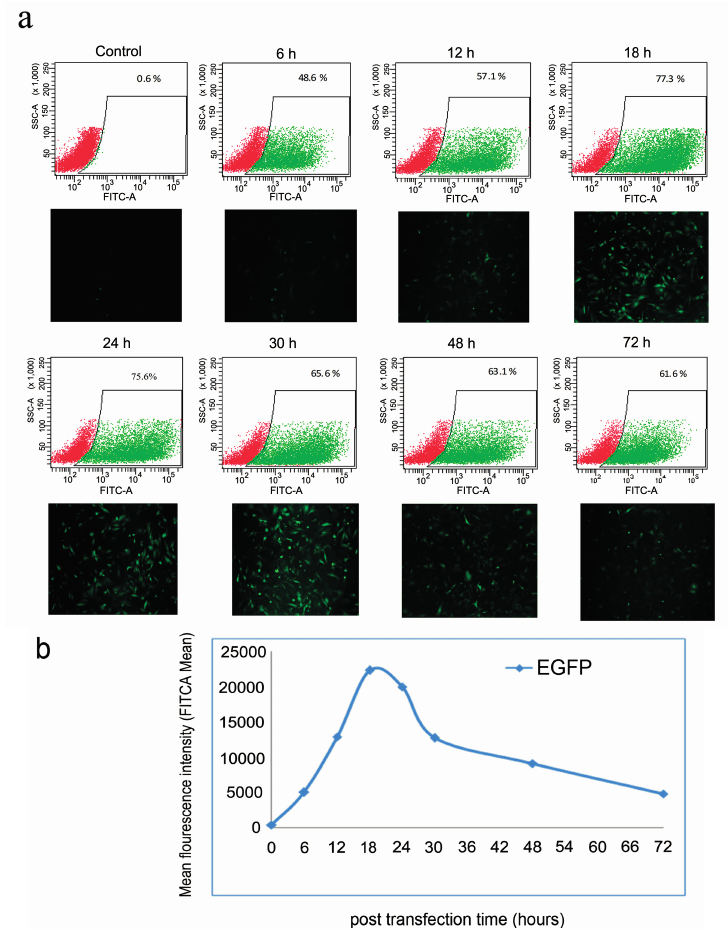
Figure 5. Kinetics and stability monitoring of the intracellular expressed proteins of the introduced factors. ( a ) Transfected cells with 1 µg of mRNA (GFP) were photographed under a fluorescence microscope (magnification 40×) and analyzed for fluorescence intensity at 6, 12, 18, 24, 48 and 72 h post transfection (green and red areas indicated the GFP- positive and GFP-negative cells, respectively); ( b ) Fluorescence Activated Cell Sorting (FACS) analysis revealed an increased intensity that reached the maximum expression at 18 h followed by decline until 72 h post